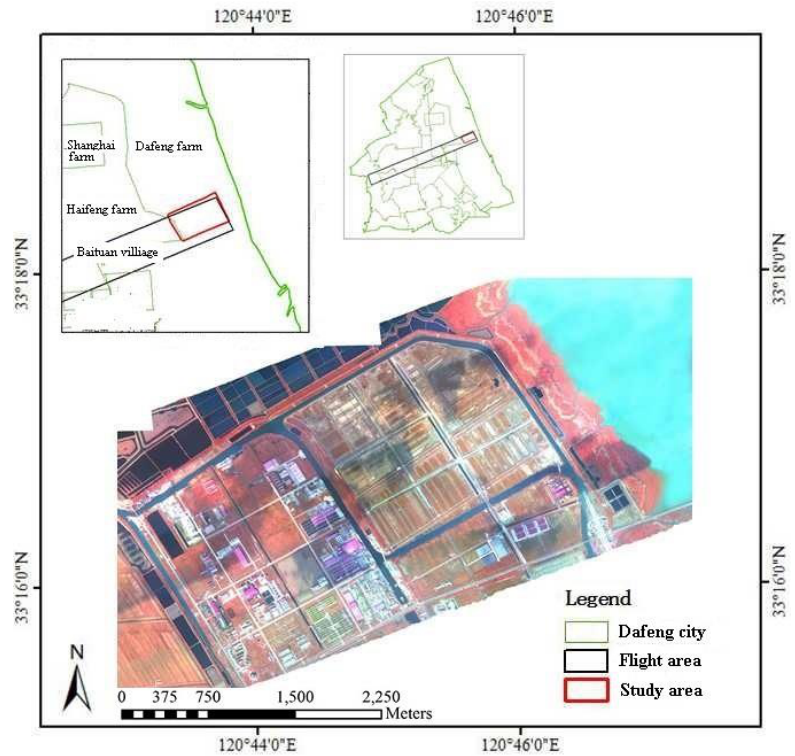
Figure 1. Study area: Dafeng, Jiangsu Province.